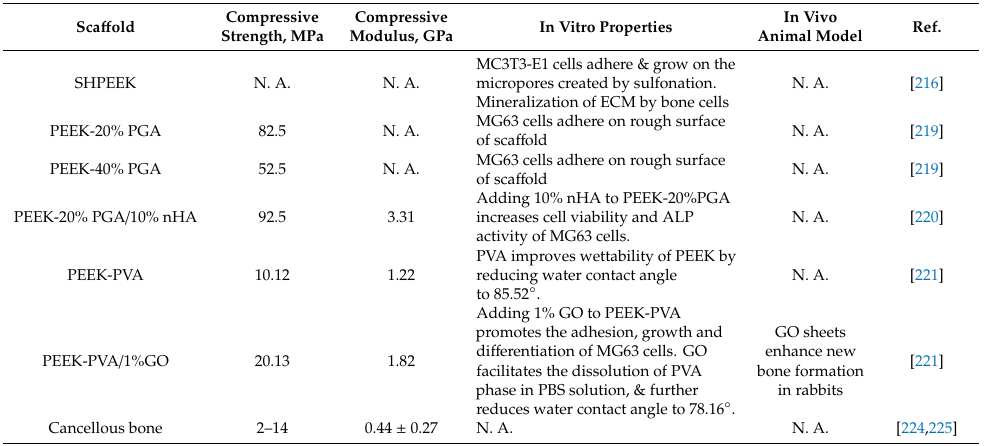
Table 4. Compressive mechanical properties, in vitro and in vivo animal test results of 3D-printed PEEK-based sca ff